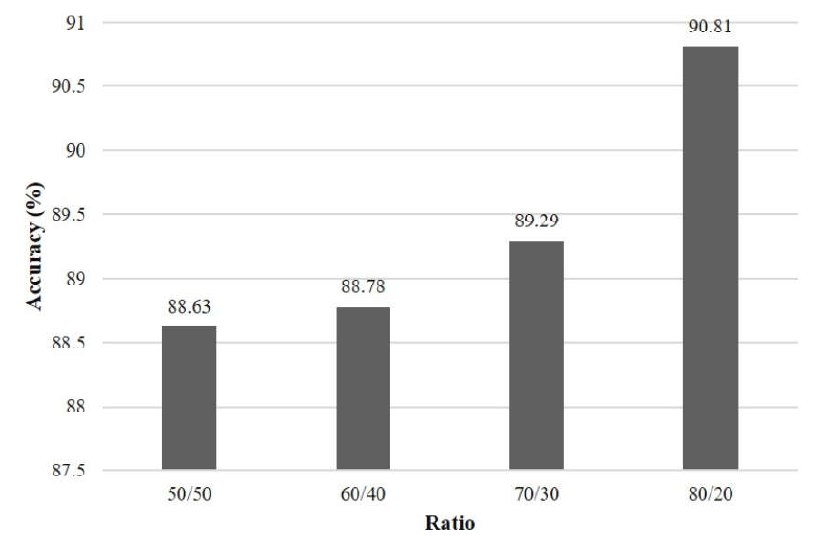
Figure 9. The recognition accuracies (%) of MMFN with the training and test samples under different